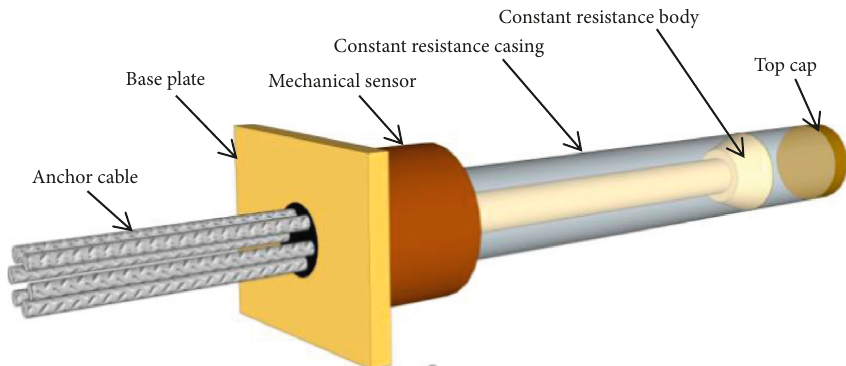
Figure 1: Structure diagram of constant resistance large deformation anchor cable.